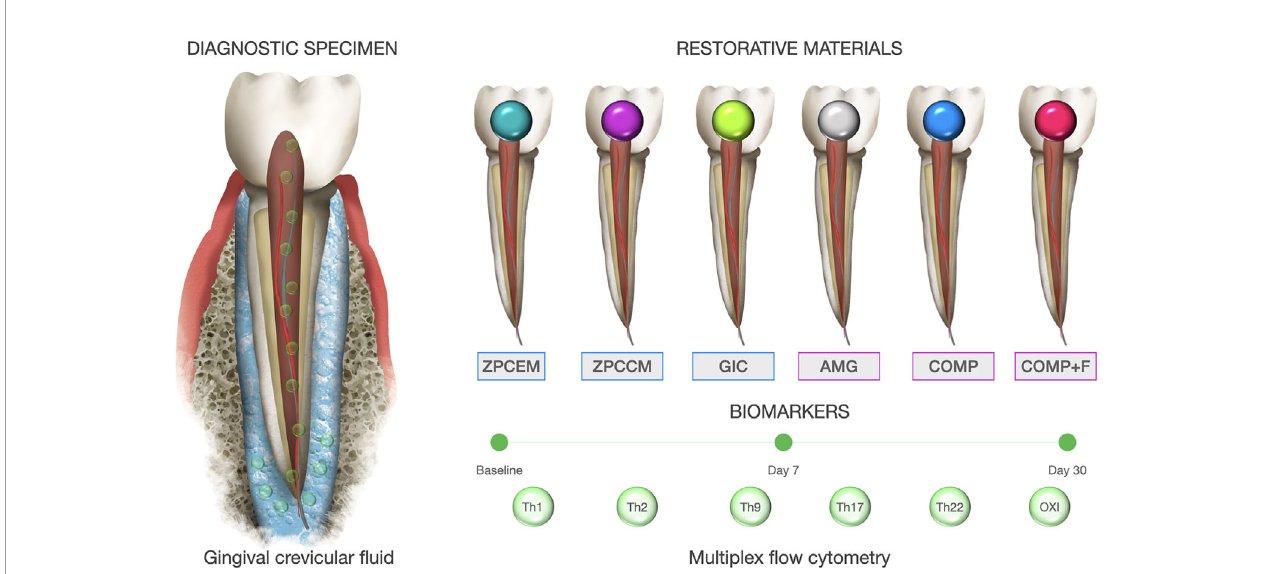
FIGURE 1 | Graphical fl owchart and study design. Superoxide dismutase (SOD), expressed as U SOD/mg proteins. 3) Reduced form of glutathione